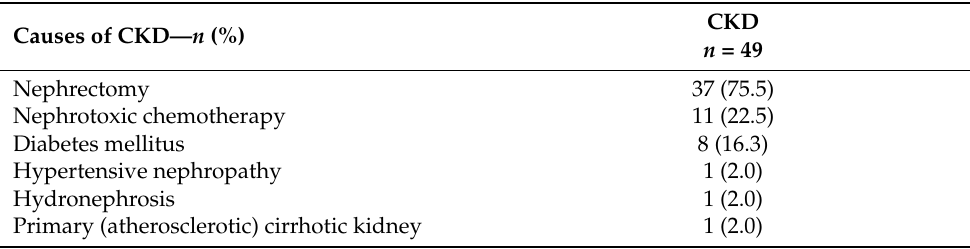
Table 2. Causes for chronic kidney